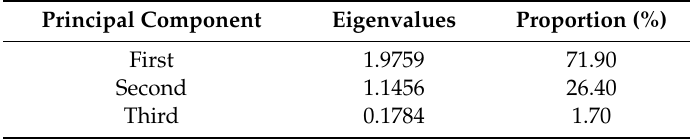
Table 7. Eigenvalues and proportions of principal components.